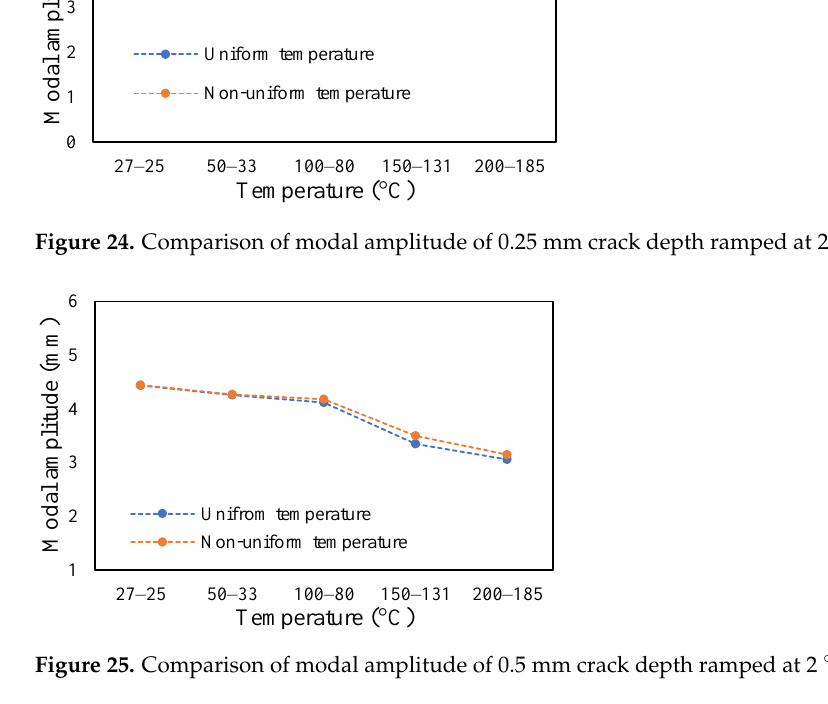
Figure 25. Comparison of modal amplitude of 0.5 mm crack depth ramped at 2 °C/min.